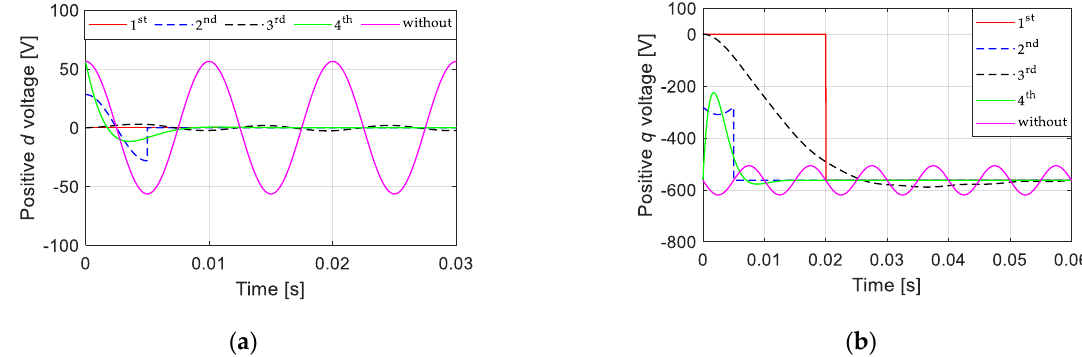
Figure 5. Unbalanced voltages in the positive dq reference frame with and without using the separation methods ( a ) positive d component; ( b ) positive q component.